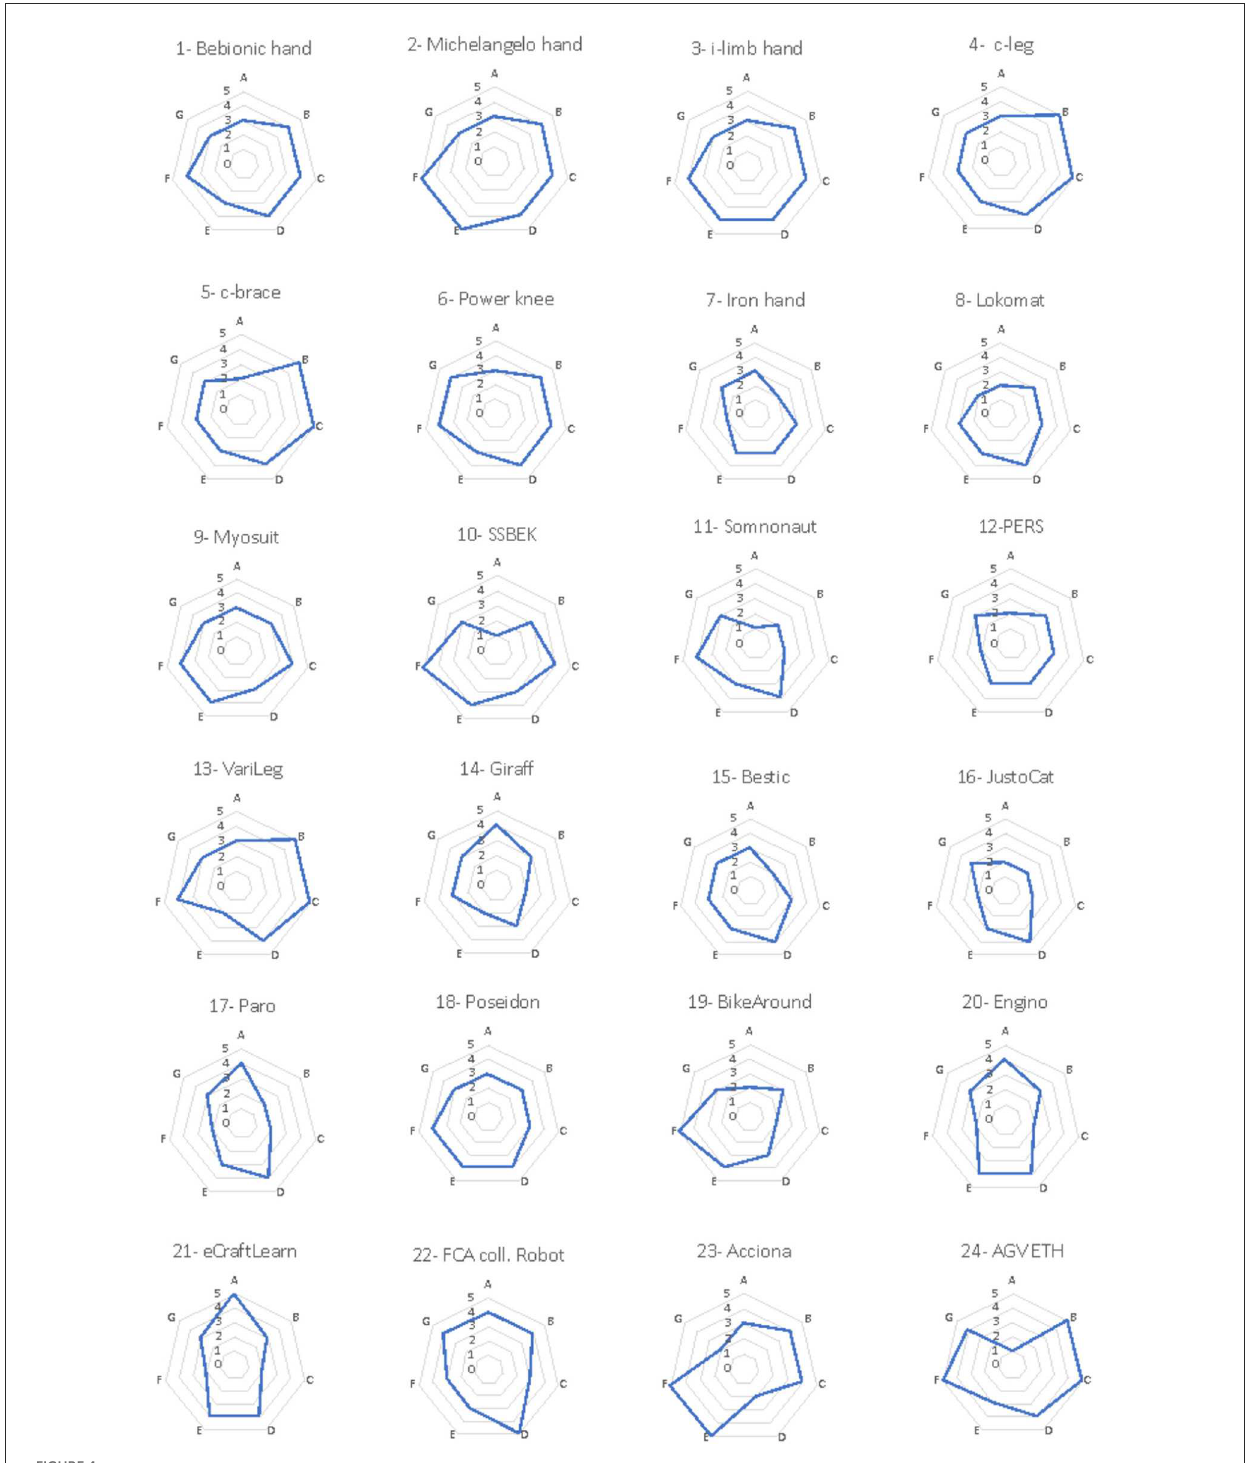
FIGURE4 Evaluation of the analyzed robotic solutions. Seven criteria were used to evaluate each of the analyzed solutions, namely, A-demand, B-usefulness, C-relative advantage, D-feasibility, E-attractiveness, F-novelty, G-level of confidence. For each criterion, an evaluation grade ranging from 1 to 5 was assigned, the obtained results were represented by a spider-net